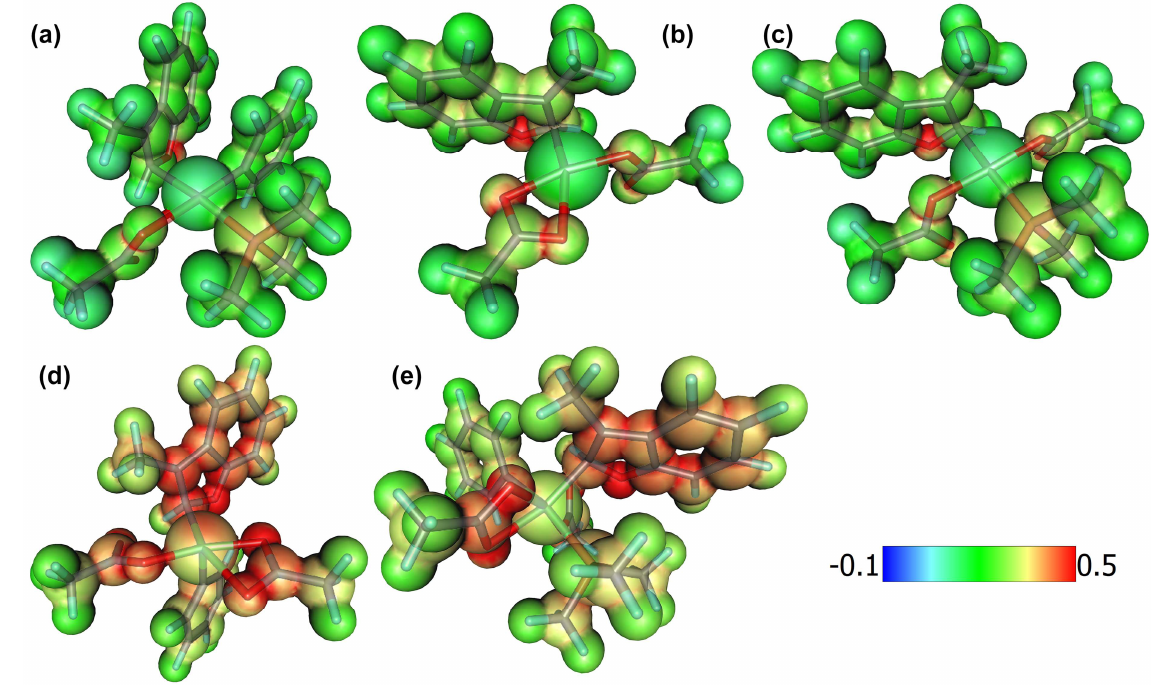
Figure 7. M apped sphere of electrostatic potential in the −0.1–0.5 range: ( a ) I_1 , ( b ) II_1 , ( c ) III_1 , Figure 7. Mapped sphere of electrostatic potential in the − 0.1–0.5 range: ( a ) I_1 , ( b ) II_1 , ( c ) III_1 , ( d ) IV_1 , and ( e ) V_1 . ( d ) IV_1 , and ( e ) V_1